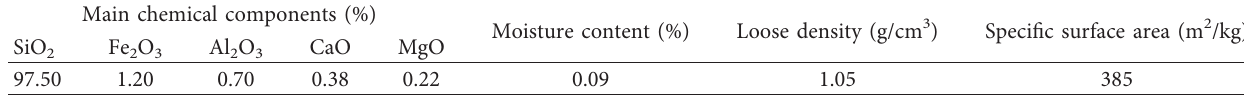
Table 3: Properties of diatomite.